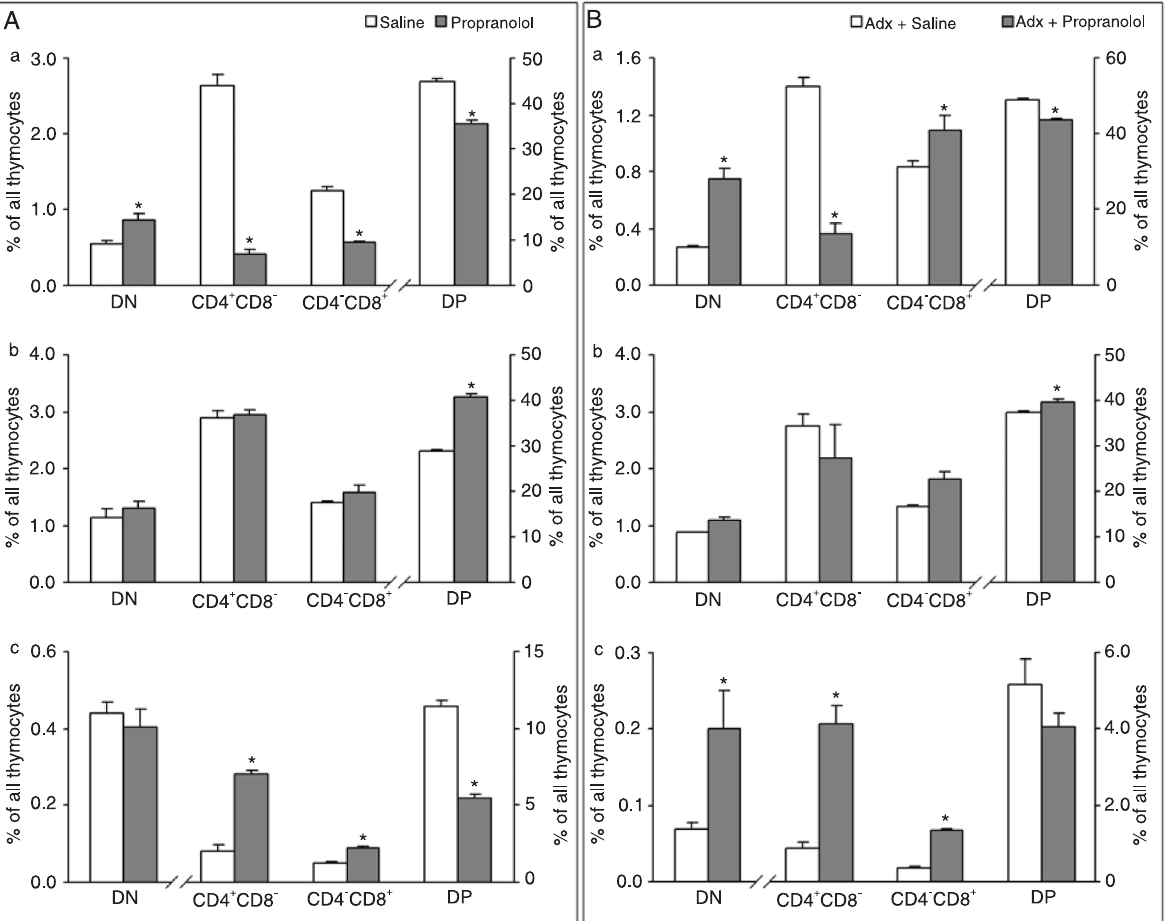
Figure 1. Differential effect of 4-day propranolol treatment on thymocyte subset distribution in non-adrenalectomized (non-Adx; panel A) and Adx adult male Dark Agouti rats (panel B). The histograms indicate the relative numbers of thymocyte subsets determined by CD4/CD8 expression with (a) undetectable (b) low and (c) high levels of TCRαβ in non-Adx and Adx rats treated with propranolol or saline. Data are reported as means ± SEM (N = 6). DN = CD4 - CD8 - , double-negative; DP = CD4 + CD8 + , double-positive. * P < 0.05 compared to the corresponding saline-treated control (two-way ANOVA followed by the Bonferroni test for post hoc